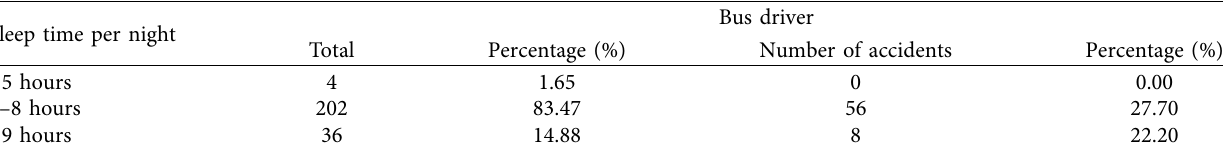
Table 13: Distribution of sleep time per